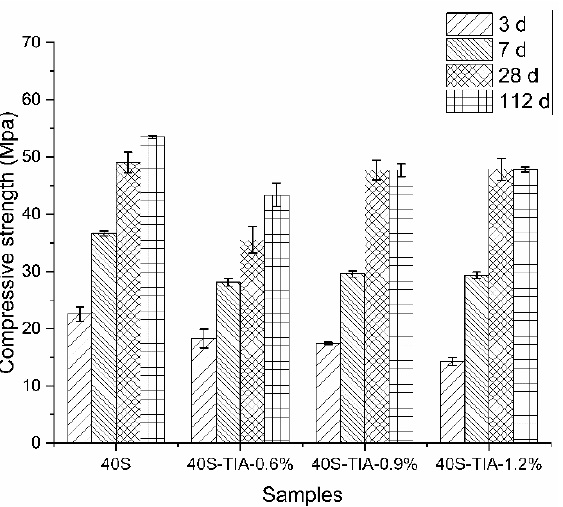
Figure 4. Compressive strength of concrete with different dosages of the NPI at 3, 7, 28, and 112 days, respectively.